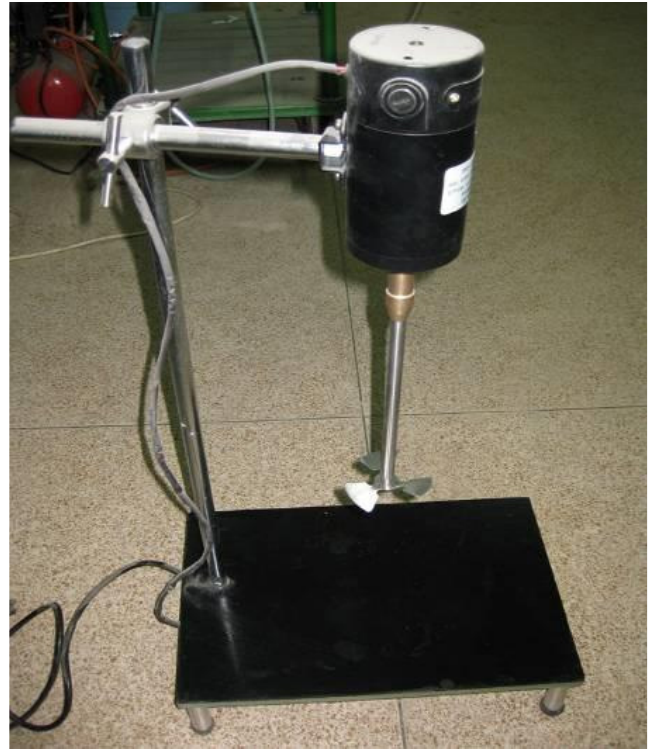
Figure 1. Physical diagram of electric mixer type D90-A.